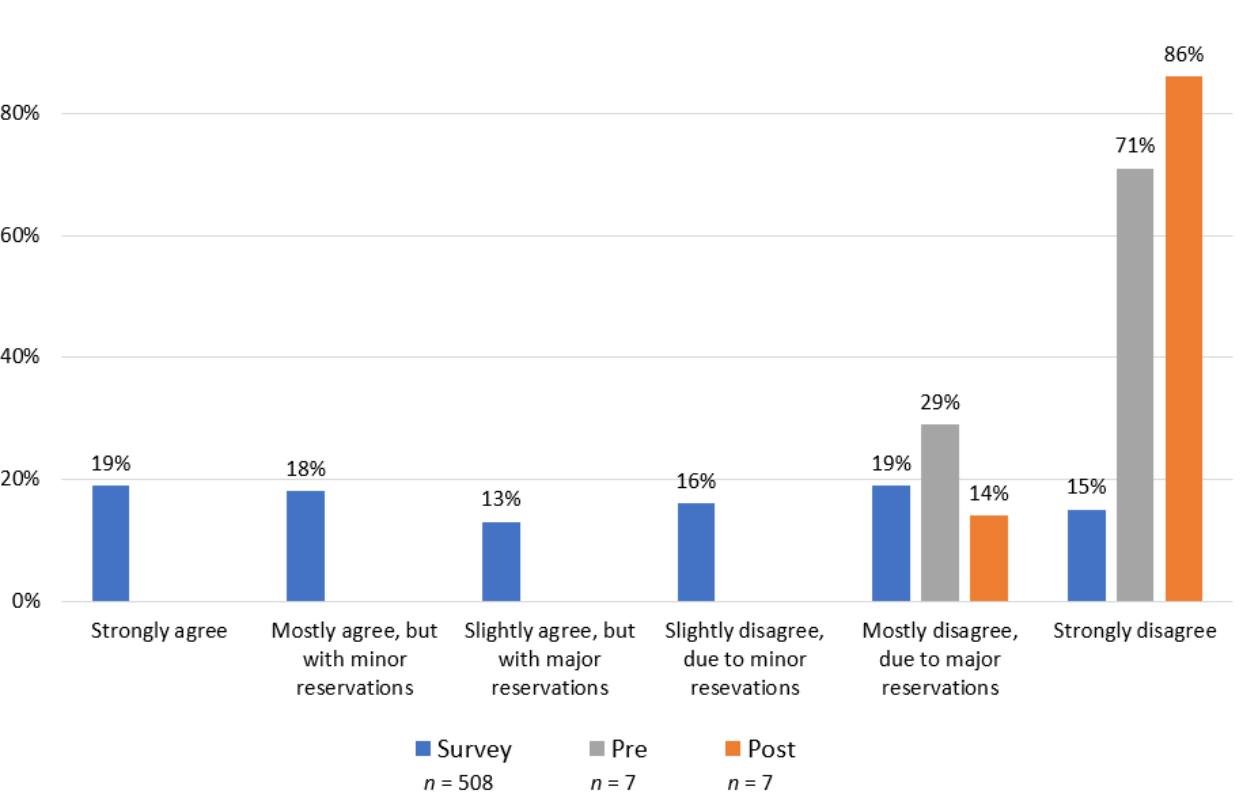
Figure 1. Voting results for the statement “No insomnia medication should be used on a daily basis for durations longer than 3 weeks at a time”. Survey participants n = 508, seven expert panelists voted before the literature search on the statement and post-presentation of the literature.